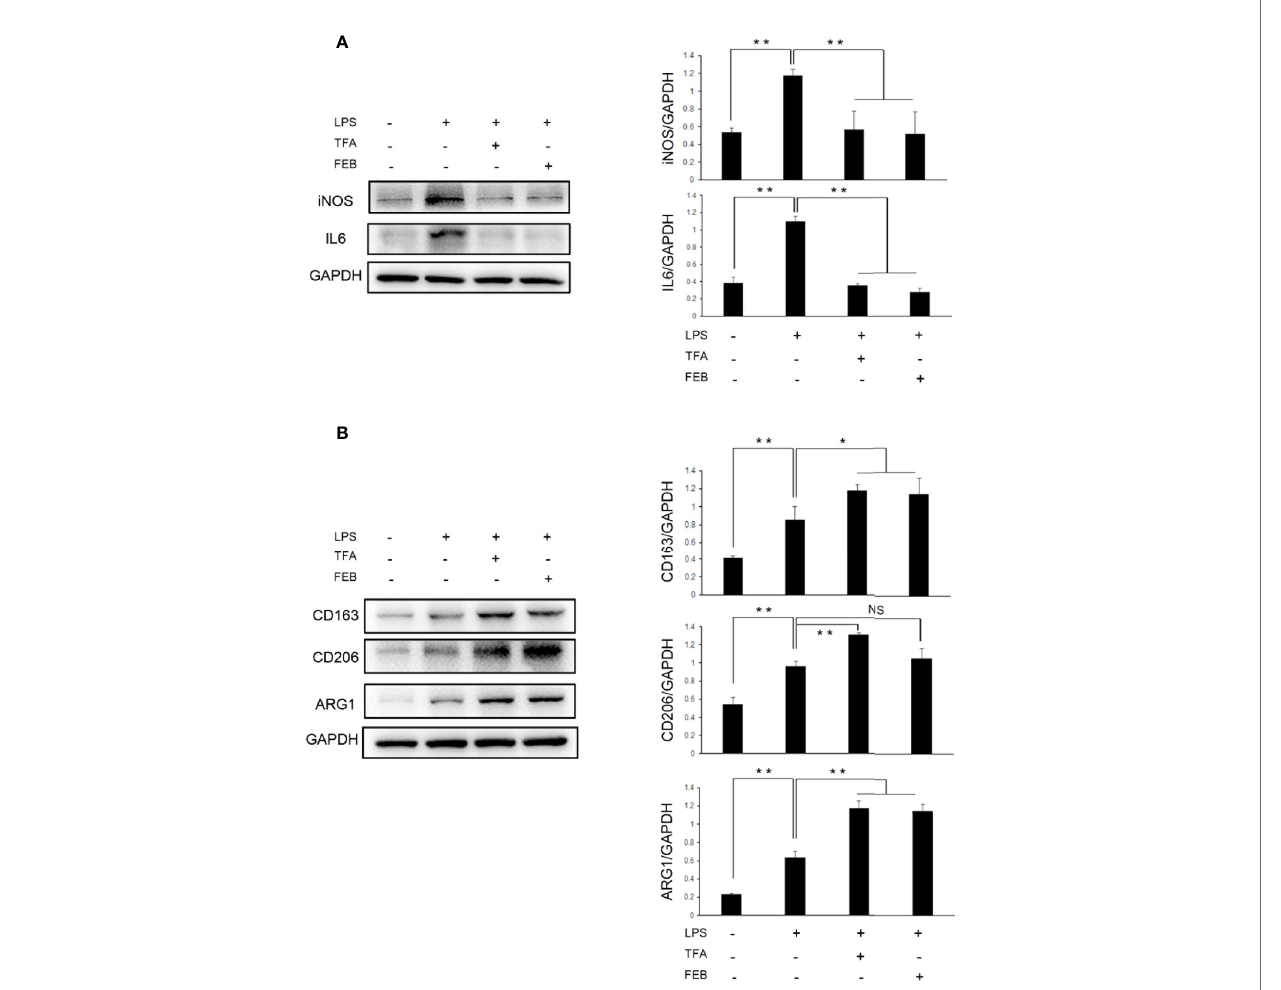
FIGURE 6 | Effects of TFA and FEB on macrophage polarization in vitro. (A) A WB analysis of iNOS and IL6 in RAW 264.7 cells exposed to LPS (100 ng/ml) with or without TFA (20 m g/ml) or FEB (100 nM) for 24 h. (B) A WB analysis of CD163, CD206, and ARG1 in RAW 264.7 cells exposed to LPS (100 ng/ml) with or without TFA (20 m g/ml) or FEB (100 nM) for 24 h. The data are expressed as the mean ± SD, (n = 3). * P < 0.05, ** P < 0.01. TFA, total fl avones of Abelmoschus manihot ; FEB, febuxostat; iNOS, inducible nitric oxide synthase; IL6, interleukin 6; LPS, lipopolysaccharide; ARG1, arginase 1; NS, not signi fi cant; WB, Western